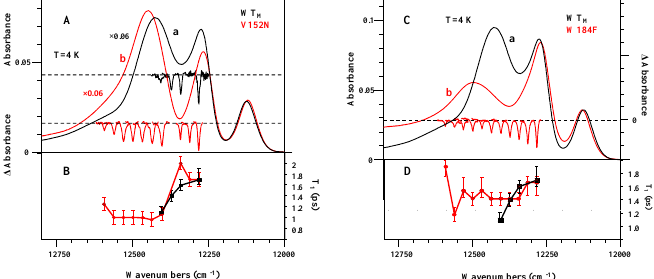
Fig. 1. Spectra a and b are the 4 K absorption spectra obtained for a WT FMO (black curve a), V152N mutant (Frame A: red; curve b) and W184F mutant (Frame C: red; curve b). The top four holes (Frame A: black curves) and the red holes (at the bottom) correspond to the extracted resonant holes observed in a typical WT FMO, V152N mutant (Frame A) and W184F mutant (Frame C) respectively. The excited-state decay times (T 1 ) calculated from hole widths (Г ZPH ) obtained as a function of burn frequency (  B ) for WT (black squares), V152N mutant (Frame B: red circles) and W16F mutant (Frame D: red squares) with corresponding error values (bars).